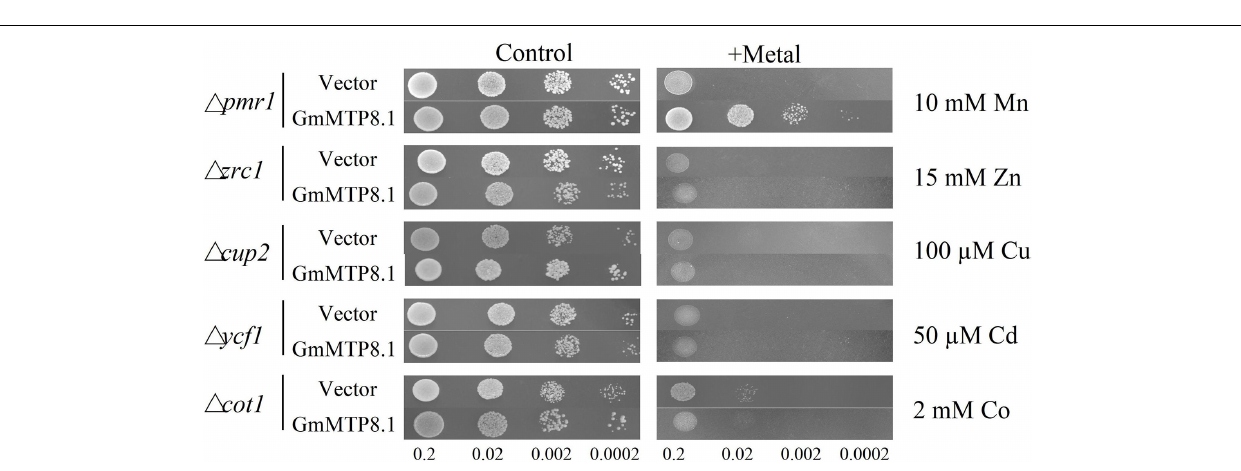
FIGURE 7 | Heterologous expression of GmMTP8.1 in different yeast mutants. The yeast mutants (cid:49) pmr1 , (cid:49) zrc1 , (cid:49) cup2 , (cid:49) ycf1, and (cid:49) cot1 harboring the pYES2 empty vector or the pYES2 - GmMTP8.1 construct were used. Yeast cells (10 µ l) with OD600 of 0.2 and four serial dilutions (10-fold) were spotted in SC-U/Gal medium added with or without 5 mM MnSO 4 , 15 mM ZnSO 4 , 100 µ M CuSO 4 , 50 µ M CdCl 2 , and 2 mM CoCl 2 for 2 day at 30 ◦